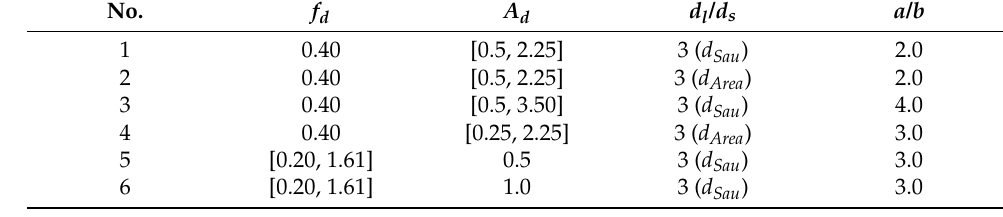
Table 4. Parameters used in cases in Figure 11.